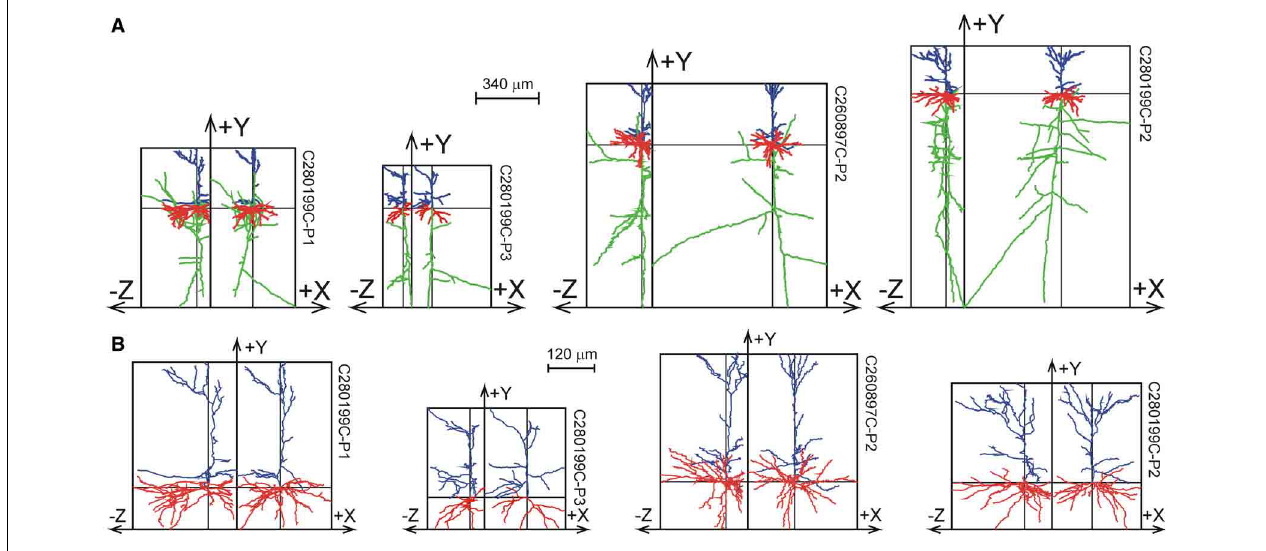
FIGURE 8 | Selection of reconstructions of 33 Wistar rat cortical L2/3 pyramidal neurons (Wang et al., 2002) plotted as projections on the XY and YZ planes. (A) Projections of both axons and dendrites with axons in green, basal dendrites in red and